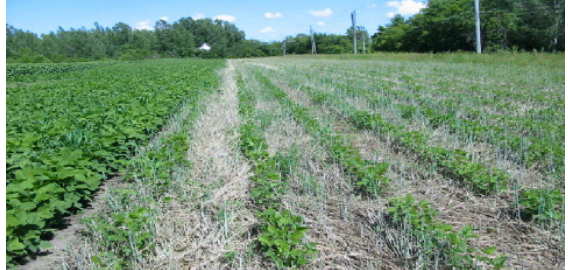
Figure 2. Organic tilled (left) and no ‐ till (right) soybeans on 12 July 2007 at Les Cèdres, Québec. Reproduced with permission from Estevez, 2008 [13].